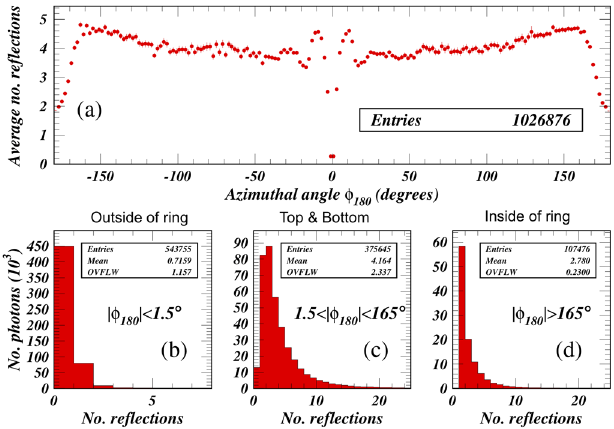
FIG. 10. Average number of prior reflections for absorbed photonssummed over (a)the full ring as a functionof the azimuthal absorption location on the vacuum chamber wall, Φ 180 . The distributions in the number of reflections are shown for the three azimuthal regions (b) j Φ 180 j < 1 . 5 °, (c) 1 . 5 ° < j Φ 180 j < 165 °, and (d) j Φ 180 j > 165 °. (Beam energy is 5.3 GeV.)